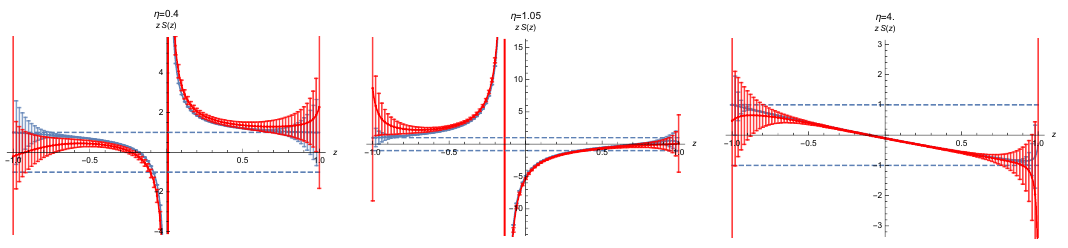
Figure 20. In red, numerical results for zS ( z ) for real z ∈ ( − 1 , 1) evaluated using method I, and error bounds evaluated using (2.17), at η = 0 . 45 , 1 . 05 , 4 . In blue, results from method II as